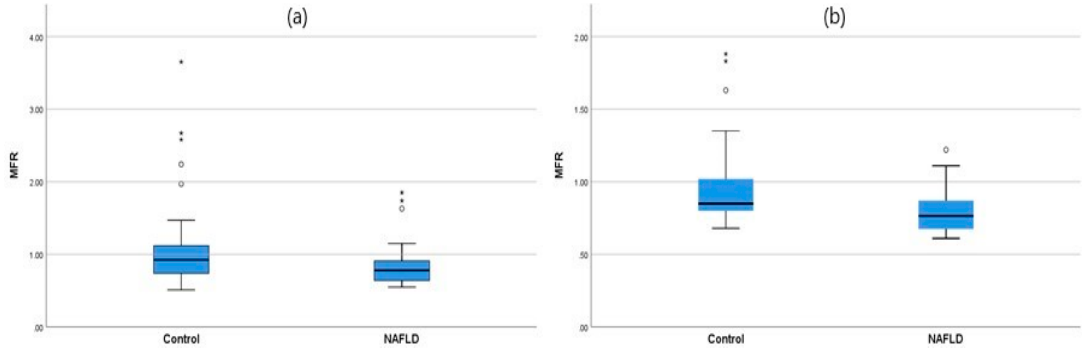
Figure 1. Box and whisker plot of median MFR (skeletal muscle-to-body fat ratio) in the control and NAFLD (non-alcoholic fatty liver disease) group in boys ( a ) and girls ( b ).